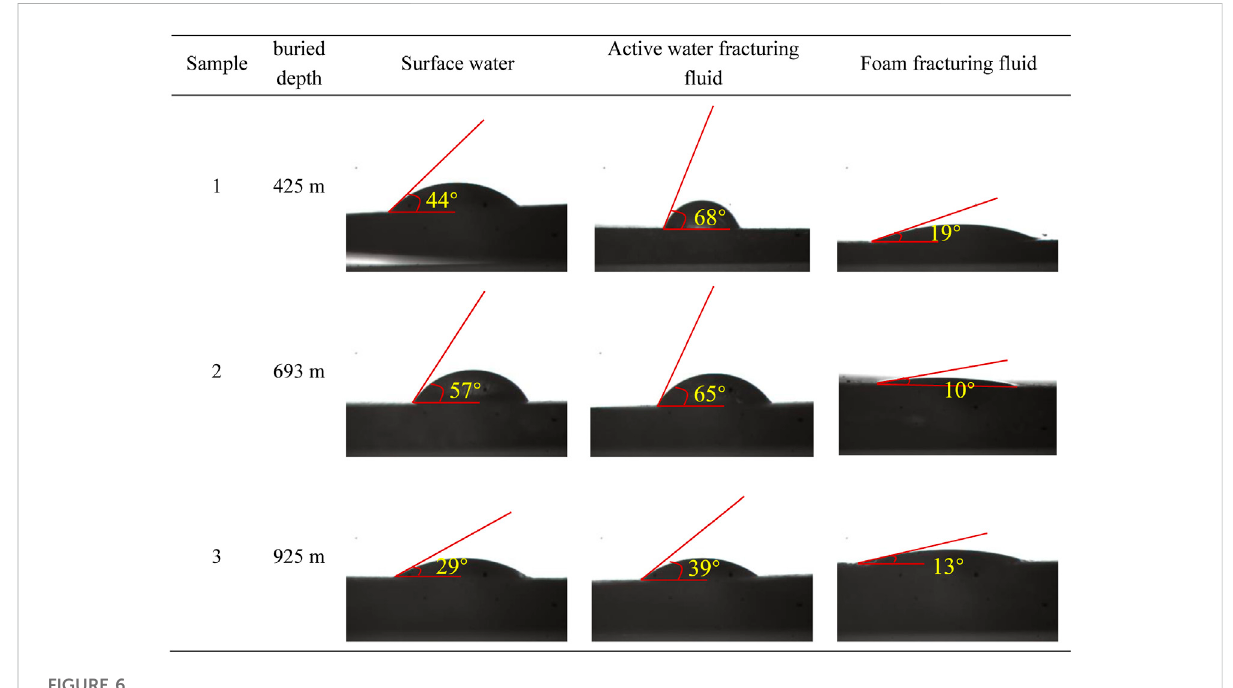
FIGURE 6 Wetting angle measurement